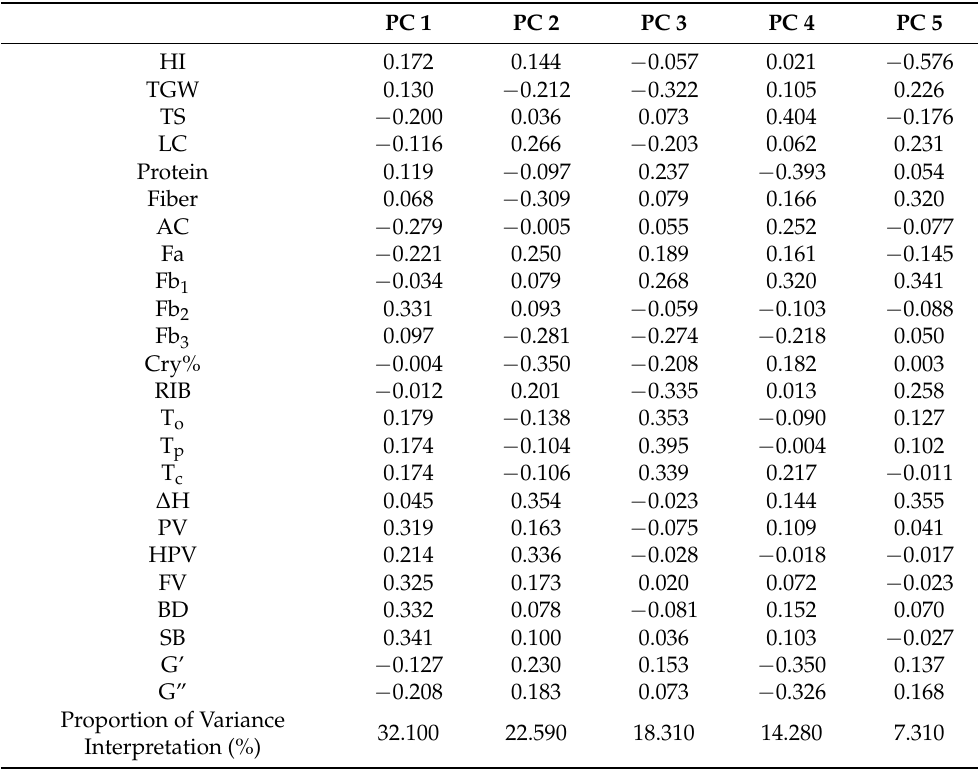
Table 6. Eigenvector values for the first five principal